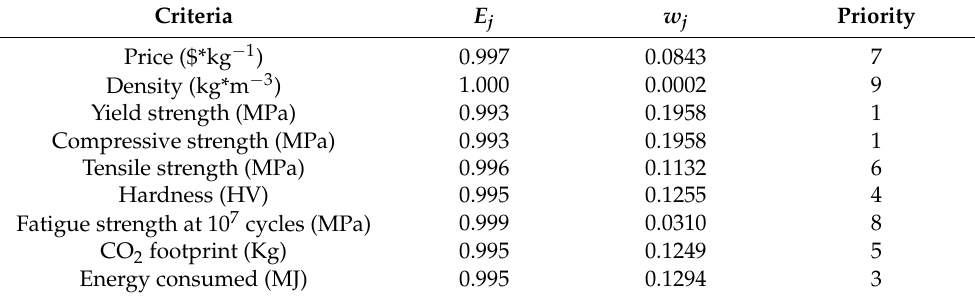
Table 8. Entropy results.